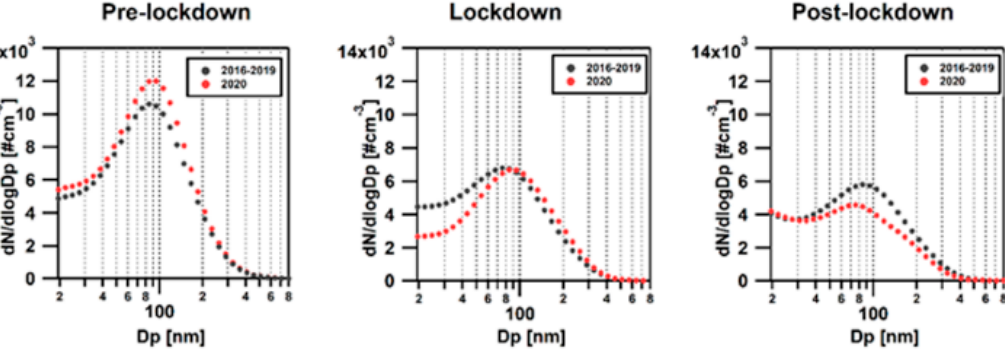
Figure 4. Size distribution for UFPs separated into three different phases (pre-lockdown, lockdown, and post-lockdown). The graphs show a comparison with the mirror period of 2016–2019.